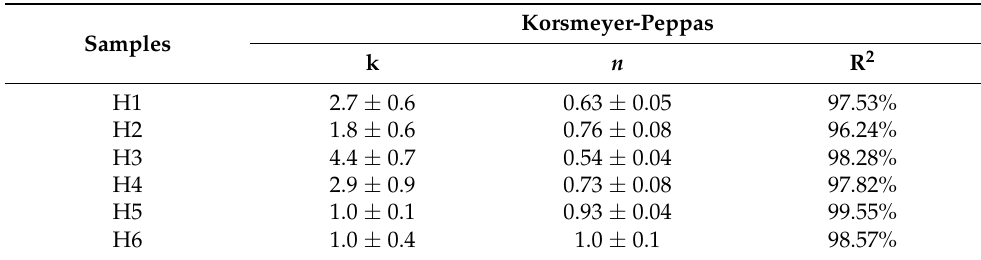
Table 3. Drug release rate constant (k), diffusion exponent ( n ), and coefficient of determination (R 2 ), according to the Korsmeyer-Peppas model.